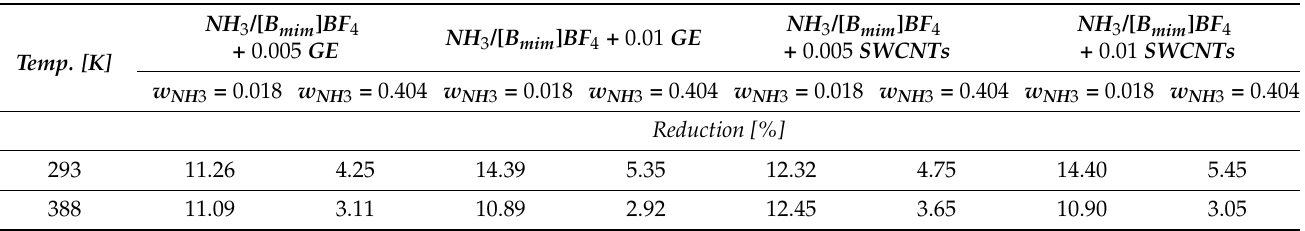
Table 6. Reduction in specific heat.